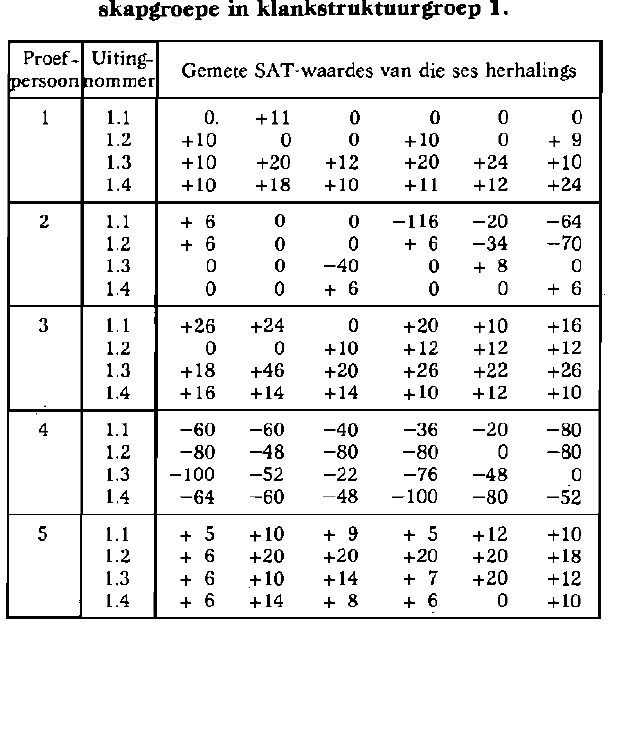
Tabel 3: Die gemete SAT-waardes van die ses herhalings van eenhede in die verskillende artikulasie-eien- skapgroepe in klankstruktuurgroep 1.